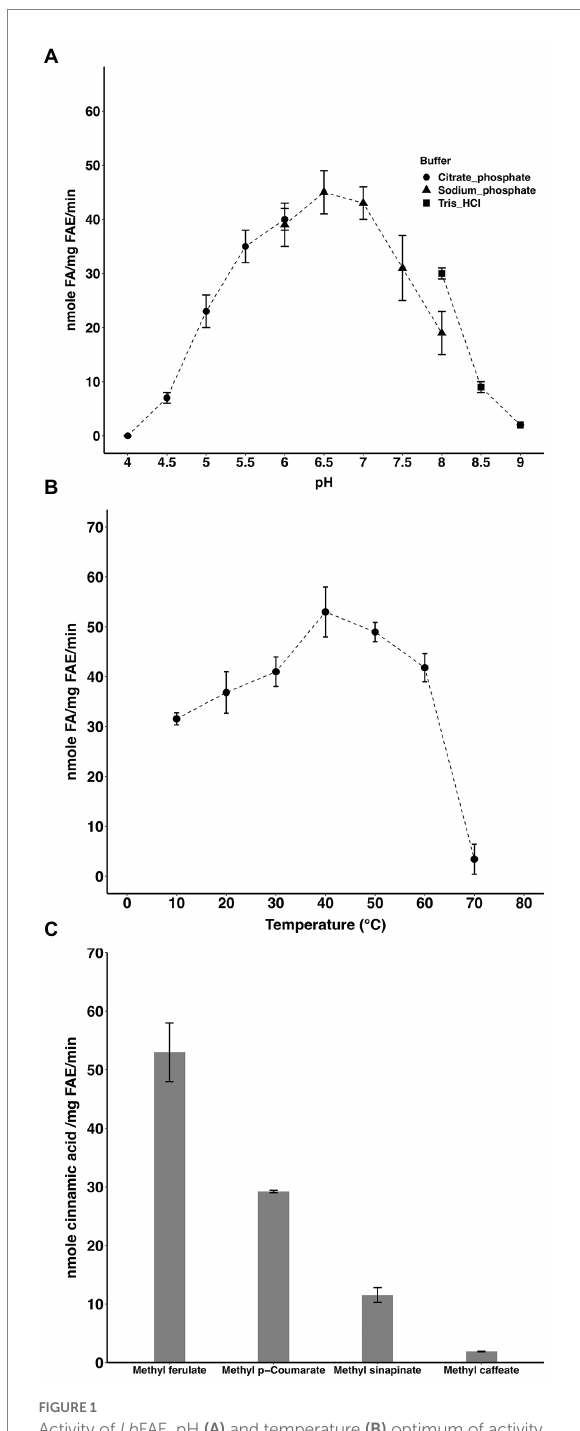
FIGURE 1 Activity of Lb FAE. pH (A) and temperature (B) optimum of activity with MF as substrate. (C) Activity on different hydroxycinnamic acids. Measurements were performed in triplicates and the error bars indicate the mean ±